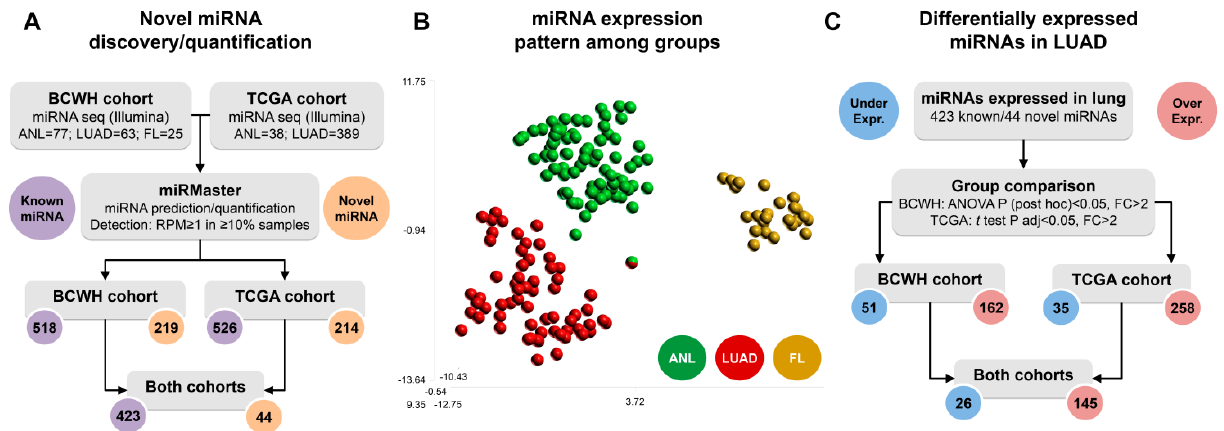
Figure 1. MiRNA expression profiles differ between lung tissue types. ( A ) Flowchart demonstrating the detection of known miRNAs and the prediction of novel miRNAs that were used in all downstream analysis; ( B ) t-SNE plot of the BCWH cohort samples, derived from expression of the 467 detected miRNAs; ( C ) Flowchart indicating the number of miRNAs differentially expressed in LUAD vs. ANL in each cohort.